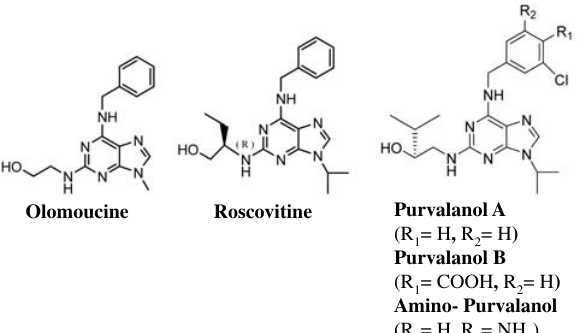
Figure 2. Structures of olomoucine, roscovitine, purvalanol A, B and